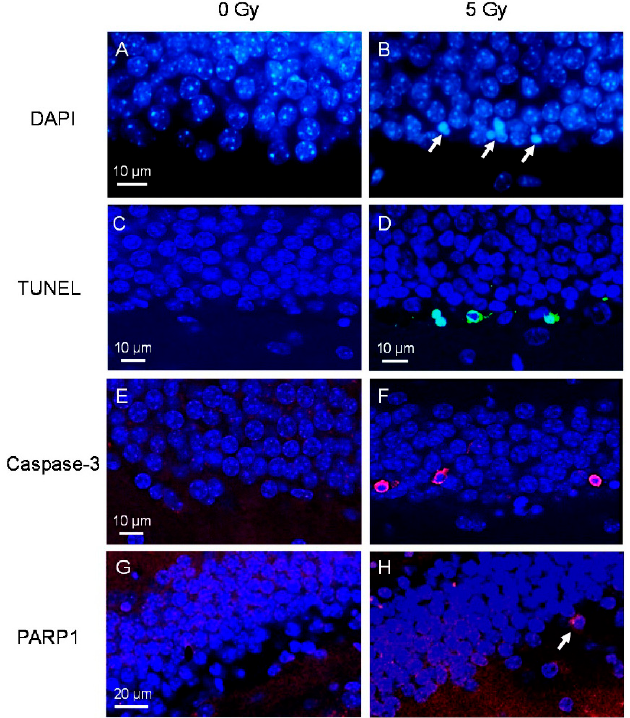
Figure 1. Apoptotic cells in the subgranular zone (SGZ) of dentate gyrus after irradiation. Apoptotic cells are rarely seen in non-irradiated controls ( A ) but are readily seen in SGZ at 8 h after a dose of 5 Gy. They demonstrate characteristic nuclear condensation and fragmentation upon 4 ′ ,6-diamidino-2-phenylindole (DAPI) staining (( B ), arrows). Apoptotic cells are also labeled by terminal deoxynucleotidyl transferase dUTP nick-end labeling (TUNEL) (( C , D ), green), caspase-3 (( E , F ), red) and poly (ADP-ribose) polymerase 1 (PARP1) (( G , H ), red, arrow).